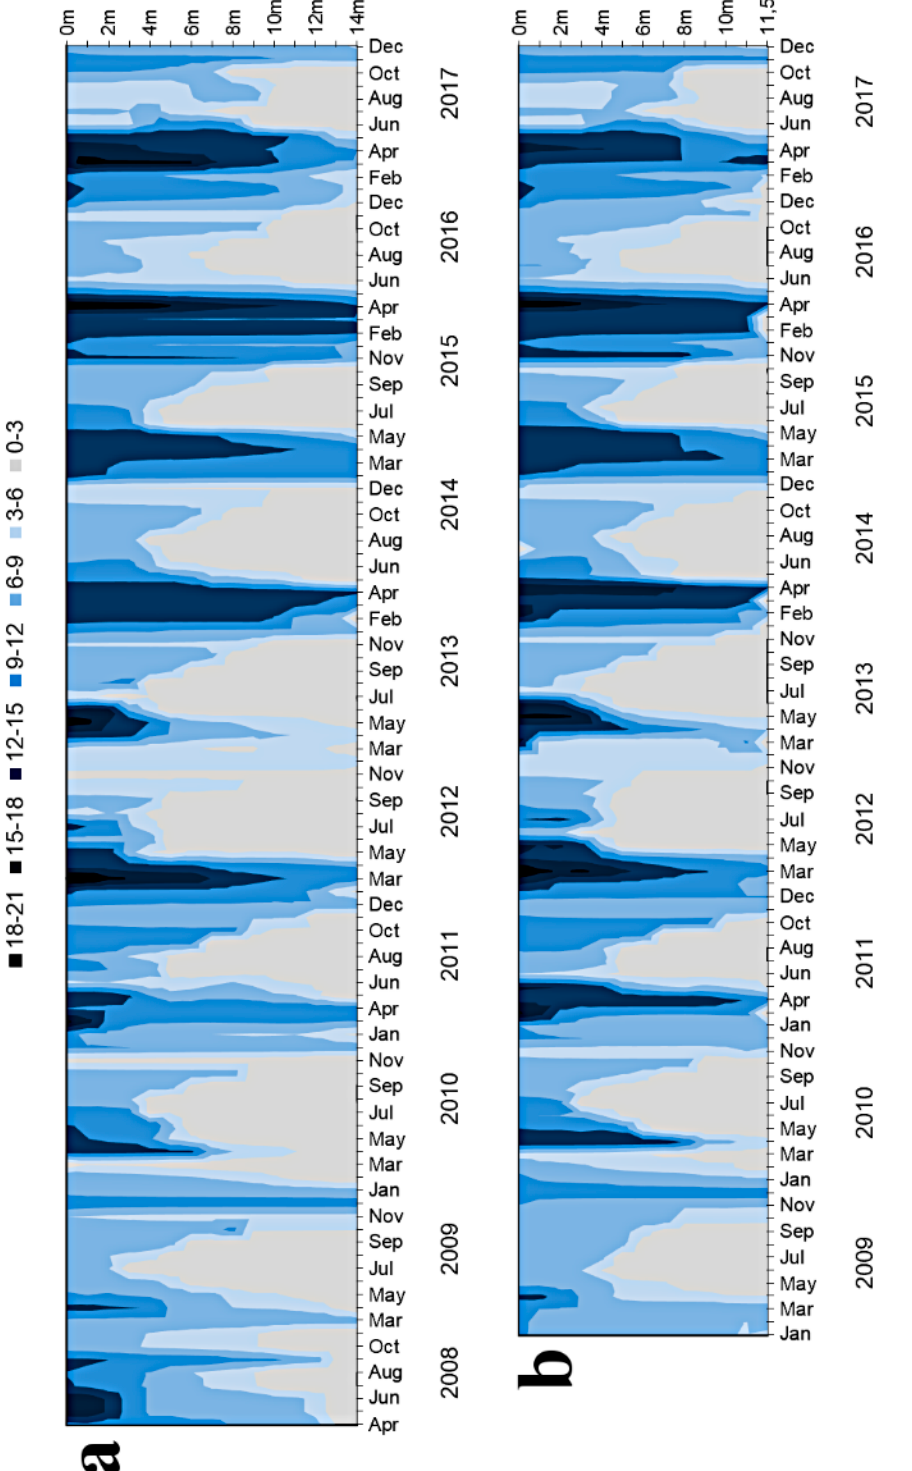
Figure 2. Changes of oxygen concentration (in mgO 2 L − 1 ) in Lake Durowskie waters in 2008–2017 at: Station I ( a ); and Station II ( b ).